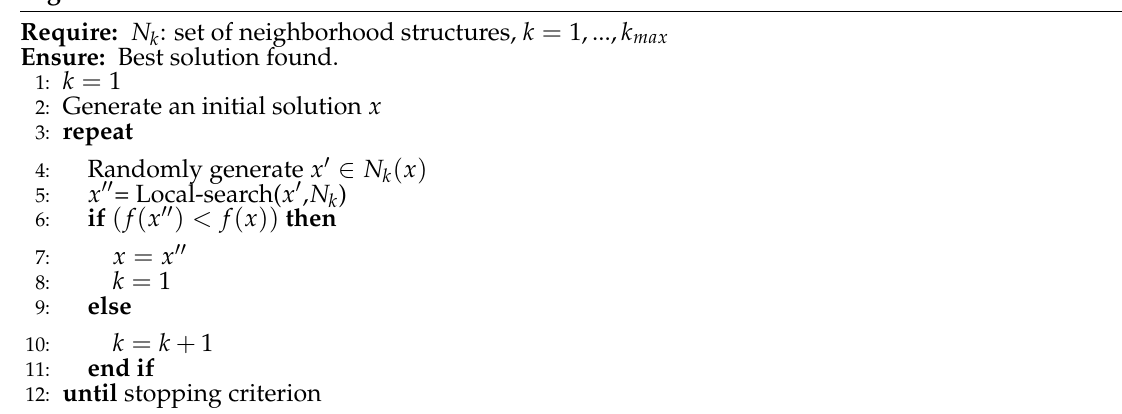
Algorithm 1 Basic